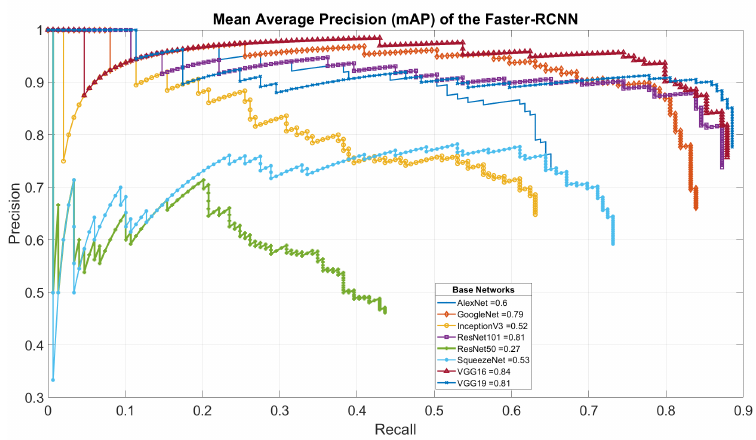
Figure 8. Mean average precision of our insect detector after training for 250 epochs with each feature extractor in Table 1.